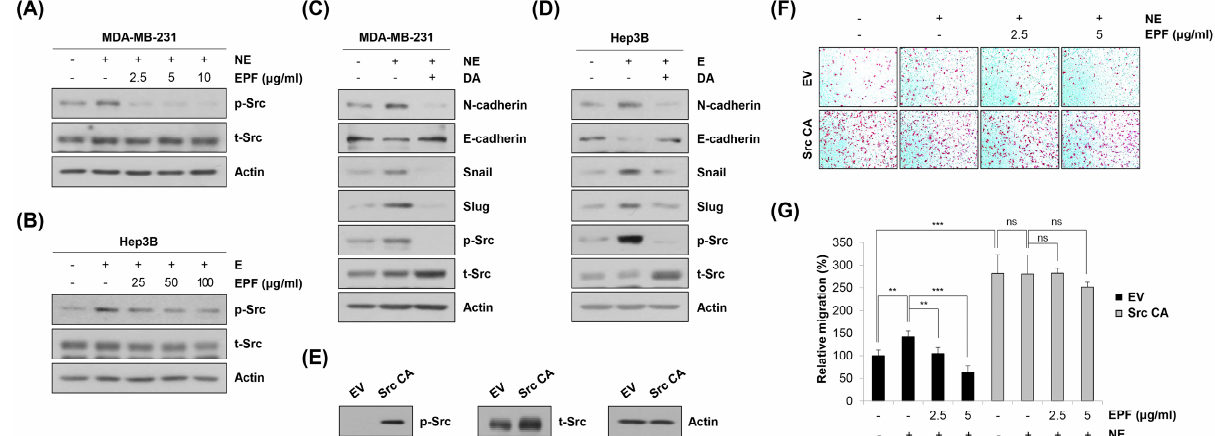
Figure 8. Src mediates the antimetastatic effect of EPF by regulating EMT. ( A , B ) MDA-MB-231 human breast cancer cells ( A ) and Hep3B human hepatocellular carcinoma cells ( B ) were pretreated with EPF at diverse concentrations (2.5-10 µ g/mL for MDA-MB-231; 25-100 µ g/mL for Hep3B) for 22 h. Cells were then treated with NE (1 µ M) or E (10 µ M) for 2 h to stimulate Src phosphorylation before harvesting. The phosphorylation level and total protein level of Src were determined by Western blot analysis. Representative images of duplicate experiments are shown. ( C , D ) MDA-MB-231 cells ( C ) and Hep3B cells ( D ) were pretreated with dasatinib (0.25 µ M) for 12 h, followed by NE (1 µ M) or E (10 µ M) treatment for a further 12 h. Expression levels of EMT marker proteins and related transcription factors were determined by Western blot analysis. Representative images of duplicate experiments are shown. ( E – G ) MDA-MB-231 cells were transfected with either empty vector (EV) or constitutively activated Src (Src CA) plasmid. At 48 h post transfection, cells were harvested, and the phosphorylation level and total protein level of Src were determined by Western blot analysis ( E ). At 48 h post transfection, cells were detached and plated into inserts of 24-well Transwell plates and cotreated with NE (1 µ M) and EPF (2.5 and 5 µ g/mL). As a chemoattractant, 10% FBS medium was used. After 24 h of incubation, migrated cells were stained and photographed ( × 100 magnification). Representative images from triplicate analyses are shown ( F ). Relative migration compared to that of untreated control cells was evaluated by counting stained cells ( G ). The data are expressed as the mean ± SD of three independent experiments. Significance was determined by the Student’s t -test (ns, not significant, ** p < 0.01, *** p < 0.001 vs. respective control). E, epinephrine; NE, norepinephrine; EPF, ethanol extract of Perilla frutescens leaves; DA, dasatinib; EV, empty vector; Src CA, constitutively activated Src